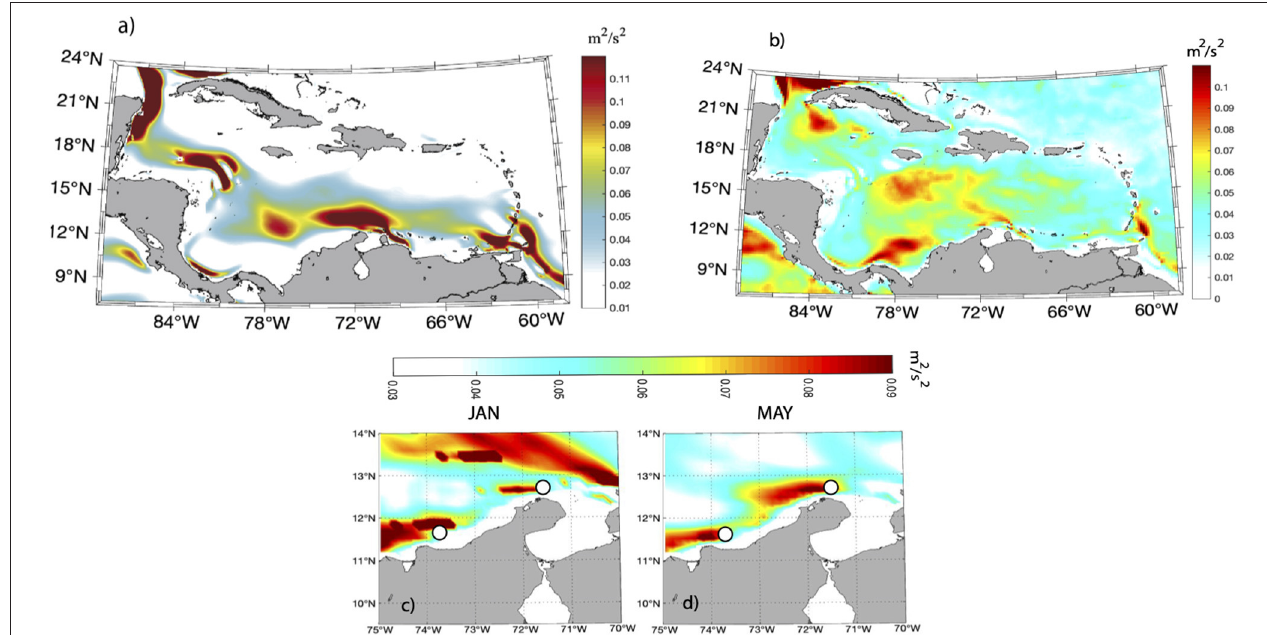
FIGURE 2 | (a) Mean Kinetic Energy ( K m ) and (b) Mean Eddy Kinetic Energy ( K e ) for the daily surface velocities for the period between 2007 and 2012. A zoom of the monthly mean values of K e during (c) January, and (d) May in La Guajira area for the period 2007–2012 where dots indicate location of ADCP. Units in m 2 · s − 2